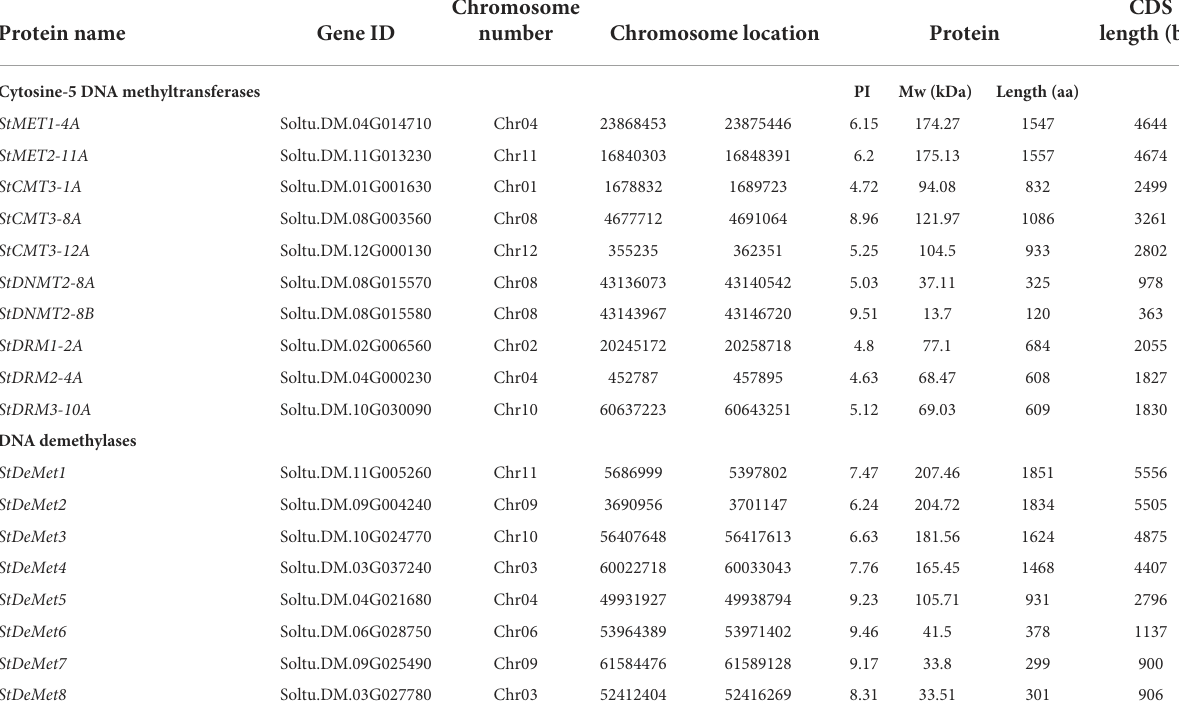
TABLE 1 Basic information of C5-MTase and DNA demethylase genes in Solanum tuberosum